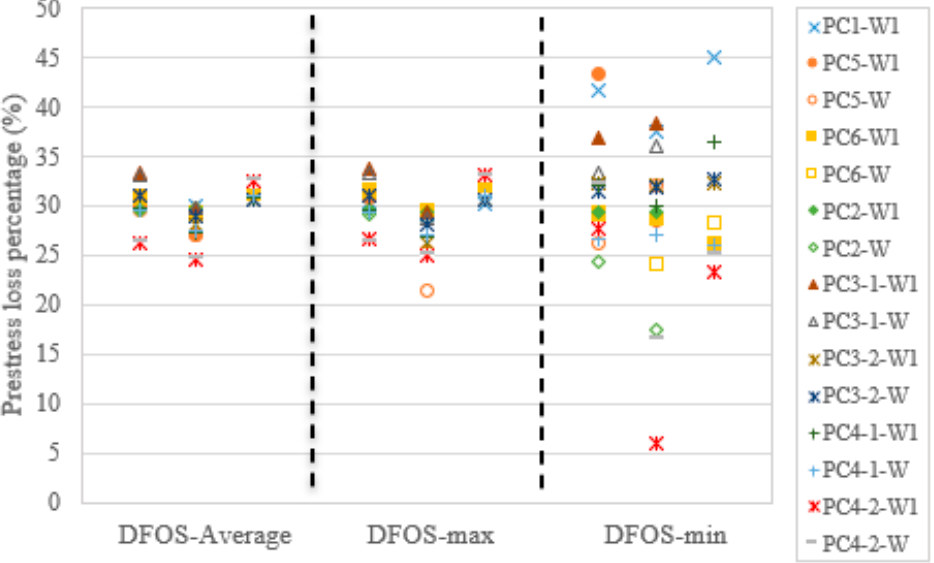
Figure 18. Prestress loss percentage for all specimens in the present test setup.